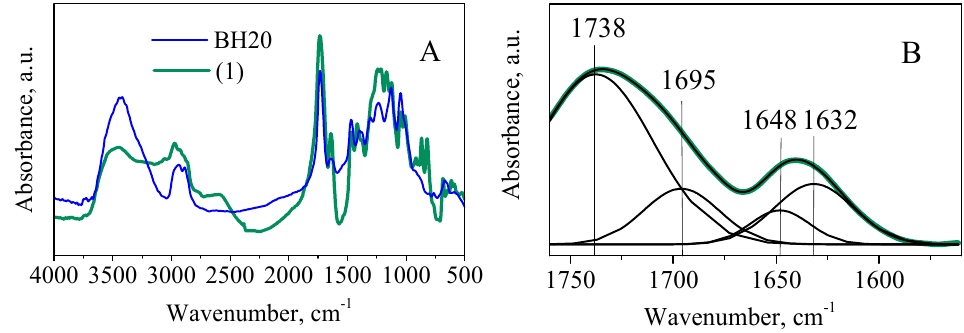
Figure 3. Infrared spectra of Boltorn H20 and compound 1 ( A ) and approximation of absorption bands of compound 1 in the region of 1760 and 1535 cm − 1 ( B ).